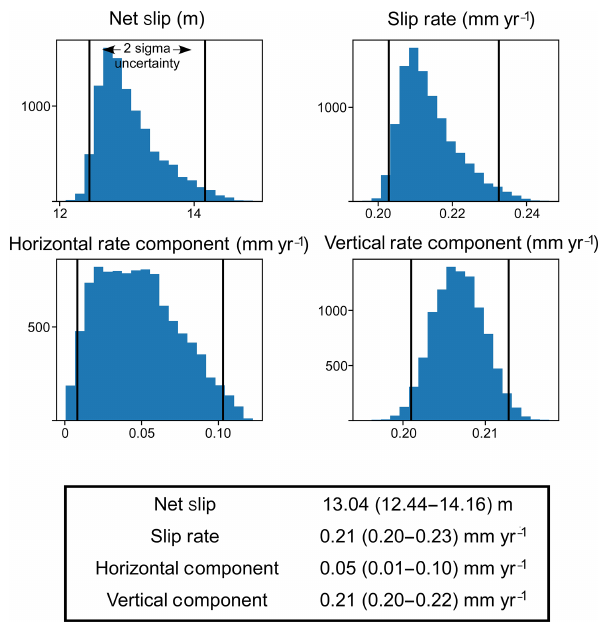
Figure 3. The slip statistics results from the fault scarp visualized in Fig. 2 and with location shown in Fig.